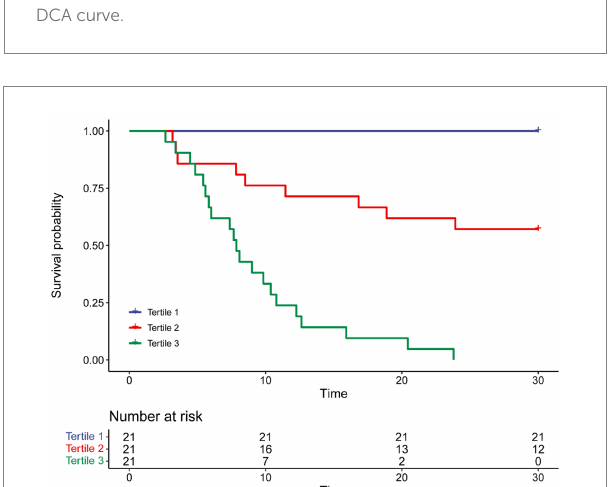
FIGURE 6 ROC curve.